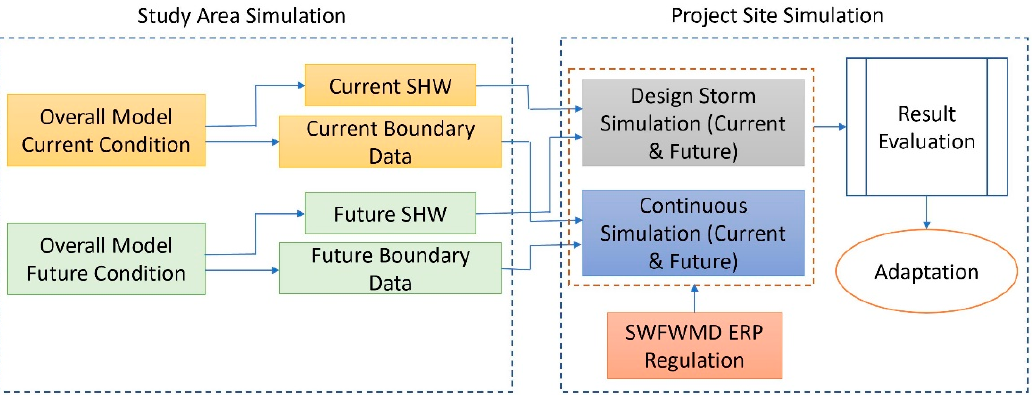
Figure 6. Components of the two-stage impact assessment framework. SHW, seasonal high water.